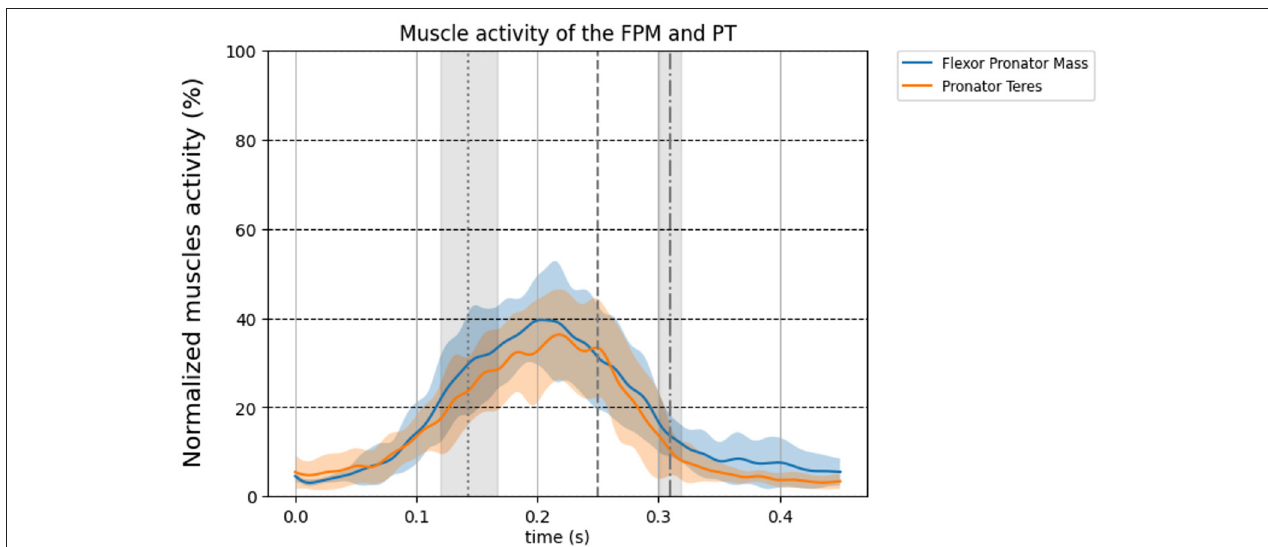
FIGURE 1 | Normalized group level EMG signal time-series for the forearm muscles corrected for EMD (50ms). The colored thick line in the time series shows the mean over all 11 pitchers and the standard deviation is shown as transparent area around the mean. Blue line: flexor pronator mass, orange line: pronator teres. The three vertical lines represent foot contact (dotted), MER (dashed), and ball release (dot dashed), respectively.